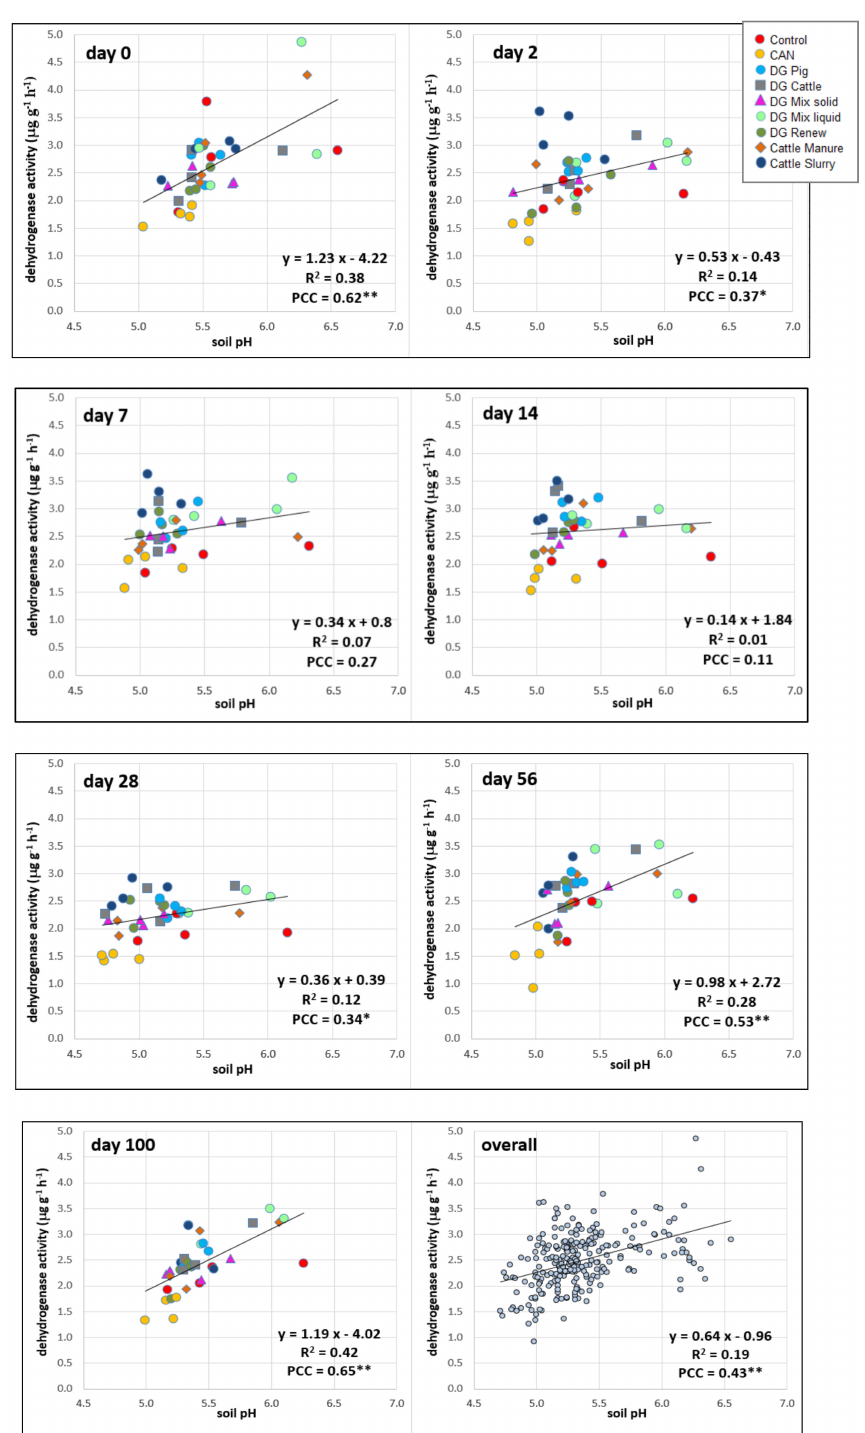
Figure 4. Regressions and Pearson’s correlation coe ffi cients (PCCs) for correlations between dehydrogenase activity in the field experiment and the pH of the soil samples. Significances: * p < 0.05; ** p < 0.01 (two-tailed t